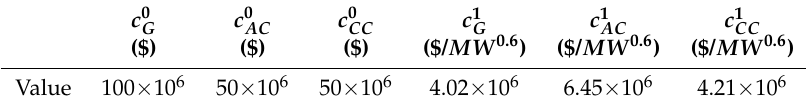
Table 4. Coefficients of capital costs for the compressors and power generator.